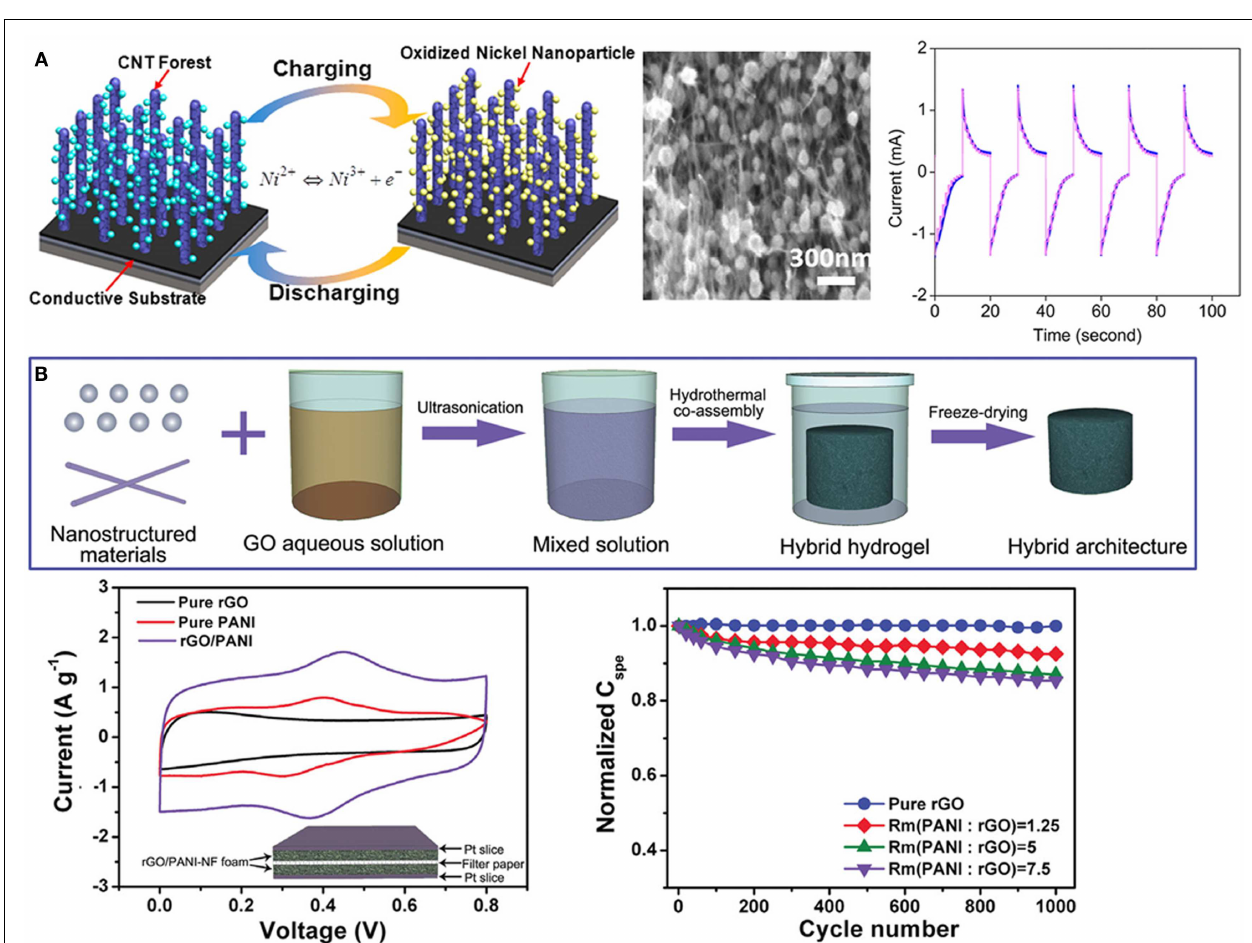
Society. (B) Schematic of preparing porous graphene hybrid structures by a hydrothermal co-assembly process and the capacitive behavior of resultant 3D graphene/polyaniline example. Adapted with permission from Niu et al. (2014). Copyright 2014WILEY-VCHVerlag GmbH & Co.